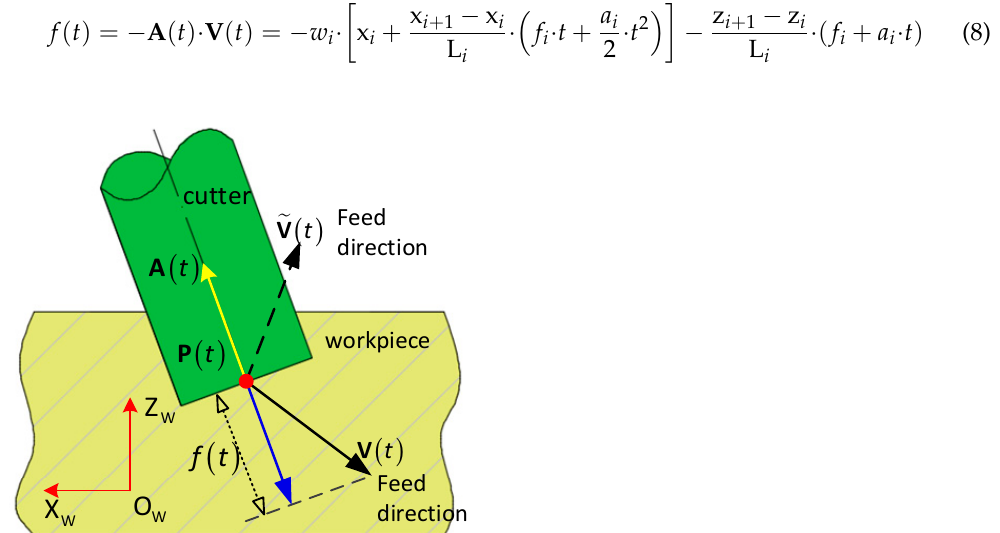
Figure 4. The feed direction of the tool tip is either leaving out of or heading into the workpiece material under the tool tip.